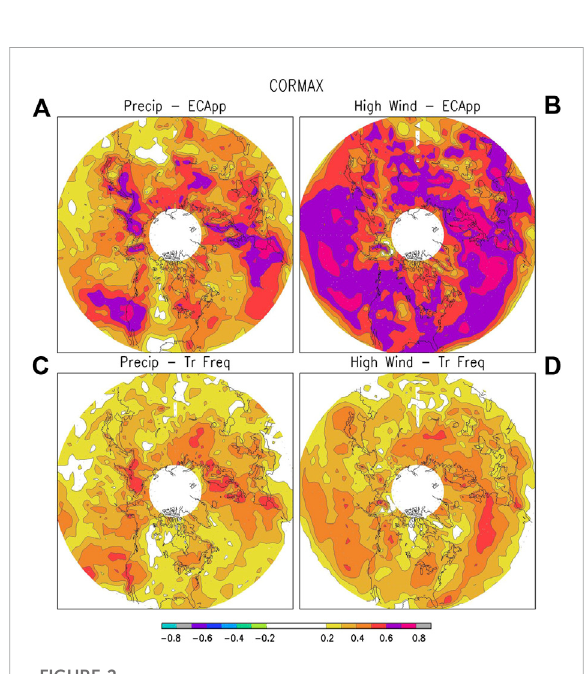
FIGURE 2 (A) CORMAX relating GPCP precipitation at each grid box to ECApp. (B) Similar to (A) , but relating the high wind index at each gridboxtoECApp. (C,D) Similarto (A) and (B) ,butforcyclonetrack frequency instead of